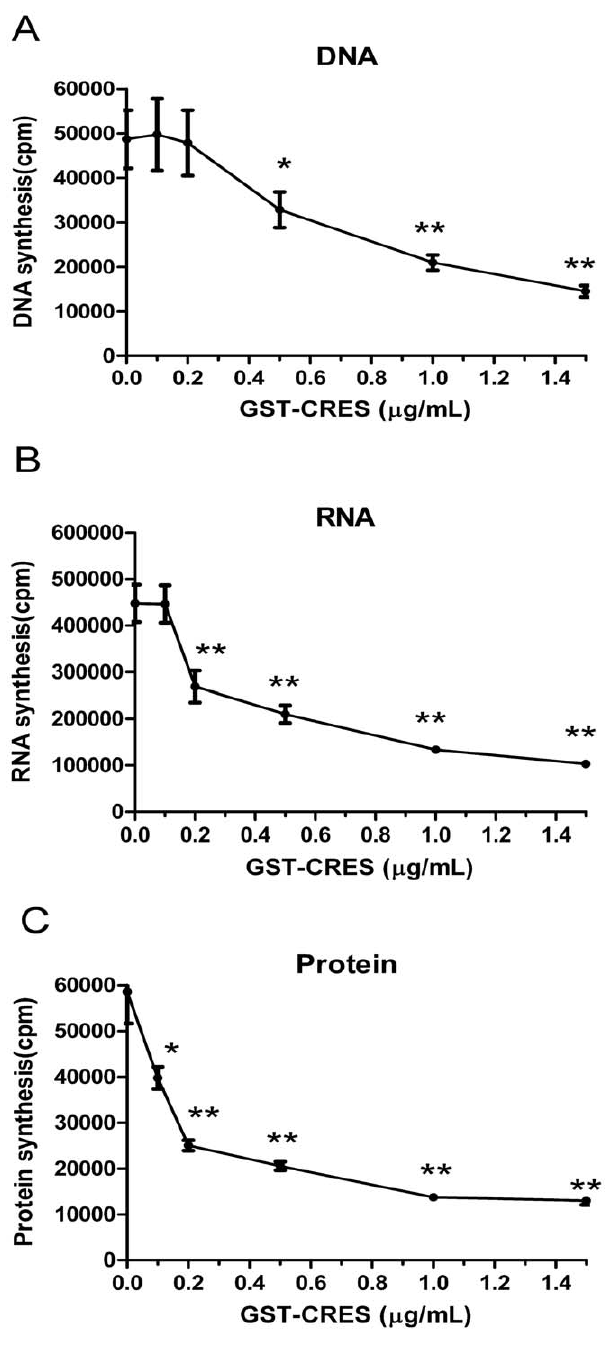
Figure 7. Macromolecular synthesis of E.coli D5 a affected by CRES. (A) DNA synthesis. (B) RNA synthesis. (C) Protein synthesis. * p , 0.05, ** p , 0.01.